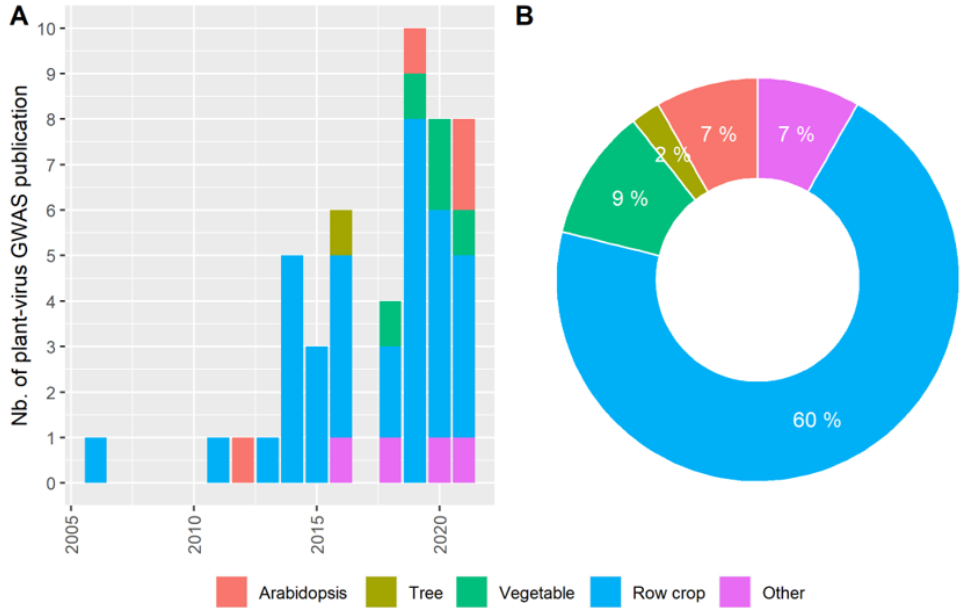
Figure 2. Overview of the publications of plant–virus GWAS: ( A ) Number of plant–virus GWAS articles published each year; ( B ) Proportion of plant–virus GWAS articles regarding the crop type. “Other” contains publications on peanut, cassava, and yam.